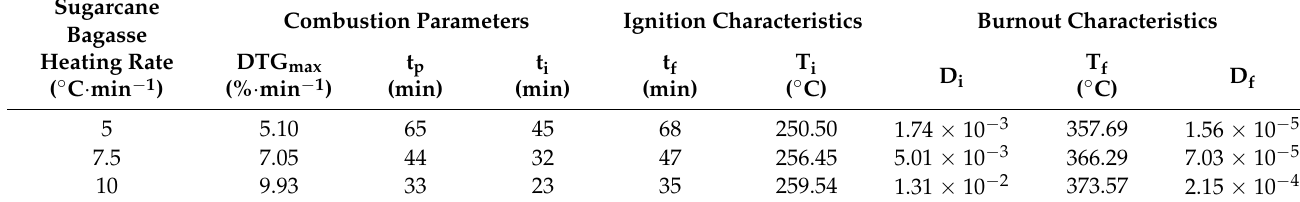
Table 3. Characteristic combustion parameters of SCB.